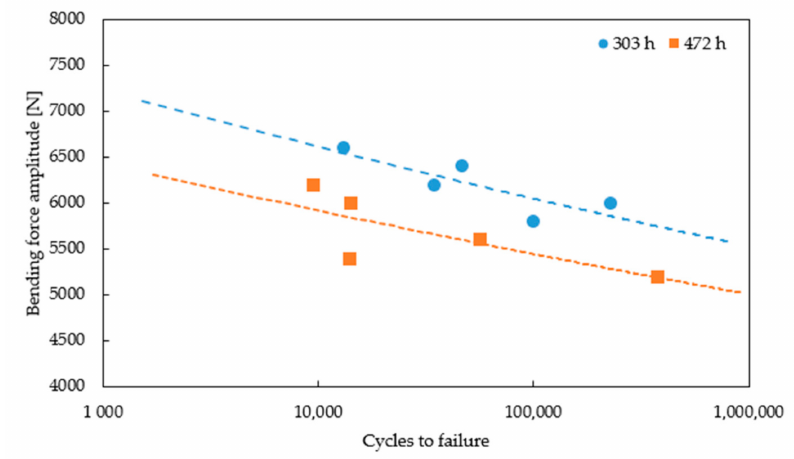
Figure 14. S-N curves for the turbine blades after different times of